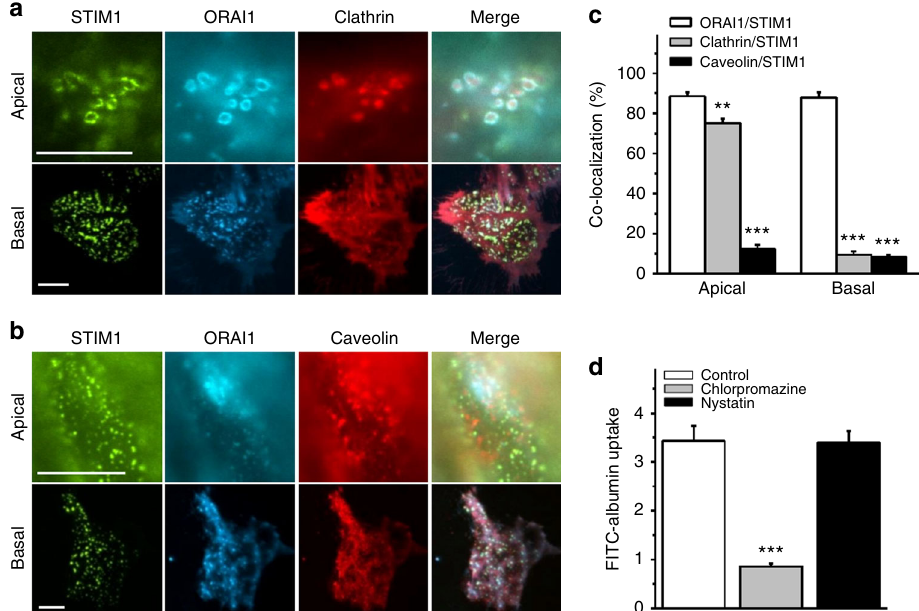
Fig. 6 Clathrin-mediated endocytosis of albumin and ORAI/STIM complexes upon Ca 2+ store depletion. a , b , Localization of STIM1-EYFP, CFP-ORAI1, clathrin-mCherry and caveolin-1-mCherry at the apical and basal membrane of PTECs. c Percentage of STIM1 punctum areas that overlapped with ORAI1, clathrin or caveolin-1 ( n = 5). d Effects of endocytosis blockers chlorpromazine (50 µ M) and nystatin (50 µ M) on the uptake of FITC-albumin by PTECs ( n = 6 for each group). Average data are presented as mean ± s.e.m. The data sets are compared by ANOVA. Statistical signi fi cance is indicated by ** P < 0.01, *** P <